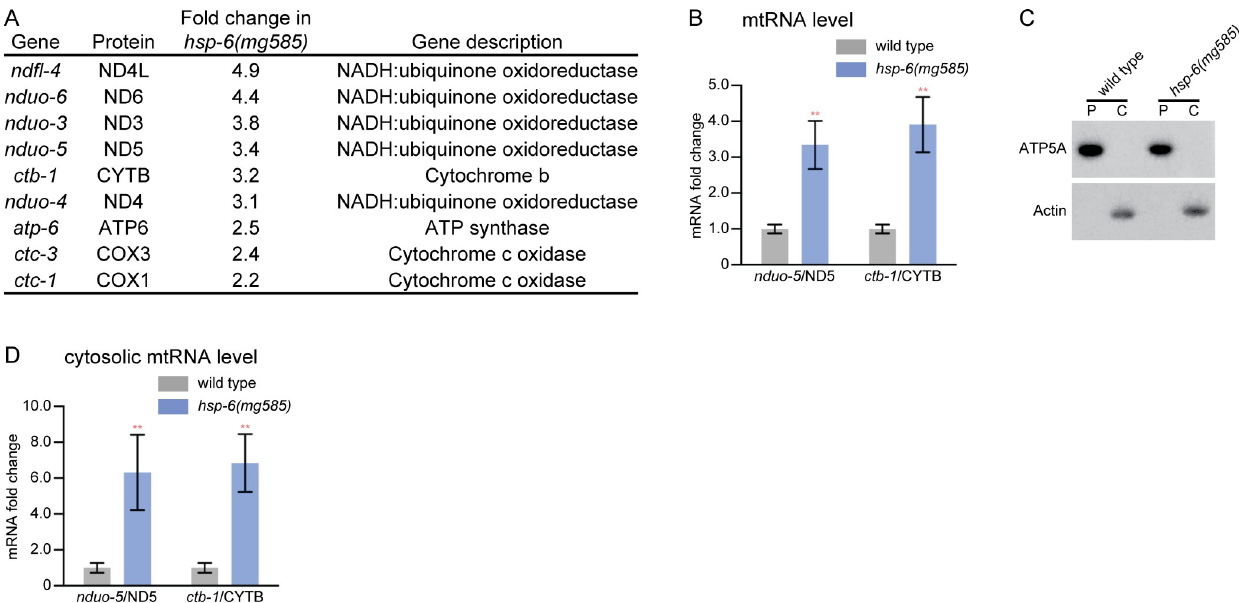
Fig 5. Release of mitochondrial RNA into the cytosol. (A) Electron transport chain genes encoded in the mitochondrial genome are induced by the hsp-6 (mg585) mitochondrial chaperone gene mutation. Of the 12 genes in the mitochondrial genome that encode subunits of electron transport chain, 9 genes were up-regulated in hsp-6(mg585) mutation. (B) The mRNA level of nduo-5 /ND5 or ctb-1 /CYTB was induced by hsp-6(mg585) mitochondrial mutation. Both nduo-5 /ND5 (NADH:ubiquinone oxidoreductase) and ctb-1 /CYTB (cytochrome b) are transcribed from the mitochondrial genome, and their expression level was evaluated by RT-qPCR assays. �� p < 0.01. (C and D) The mRNA level of nduo-5 /ND5 or ctb-1 /CYTB in the cytosol was increased in hsp-6(mg585) mitochondrial mutation. The pellet and cytosolic fractions were separated by centrifugation and probed with ATP5A and actin antibodies, respectively, to assess purification in (C). The mRNA level of nduo-5 /ND5 or ctb-1 /CYTB in the mitochondria-free cytosolic fraction was evaluated by RT- qPCR in (D). The underlying numerical data can be found in S1 data. The original blot images can be found in S1 raw images. C , cytosolic fraction; P , pellet fraction; RT-qPCR, quantitative reverse transcription PCR.